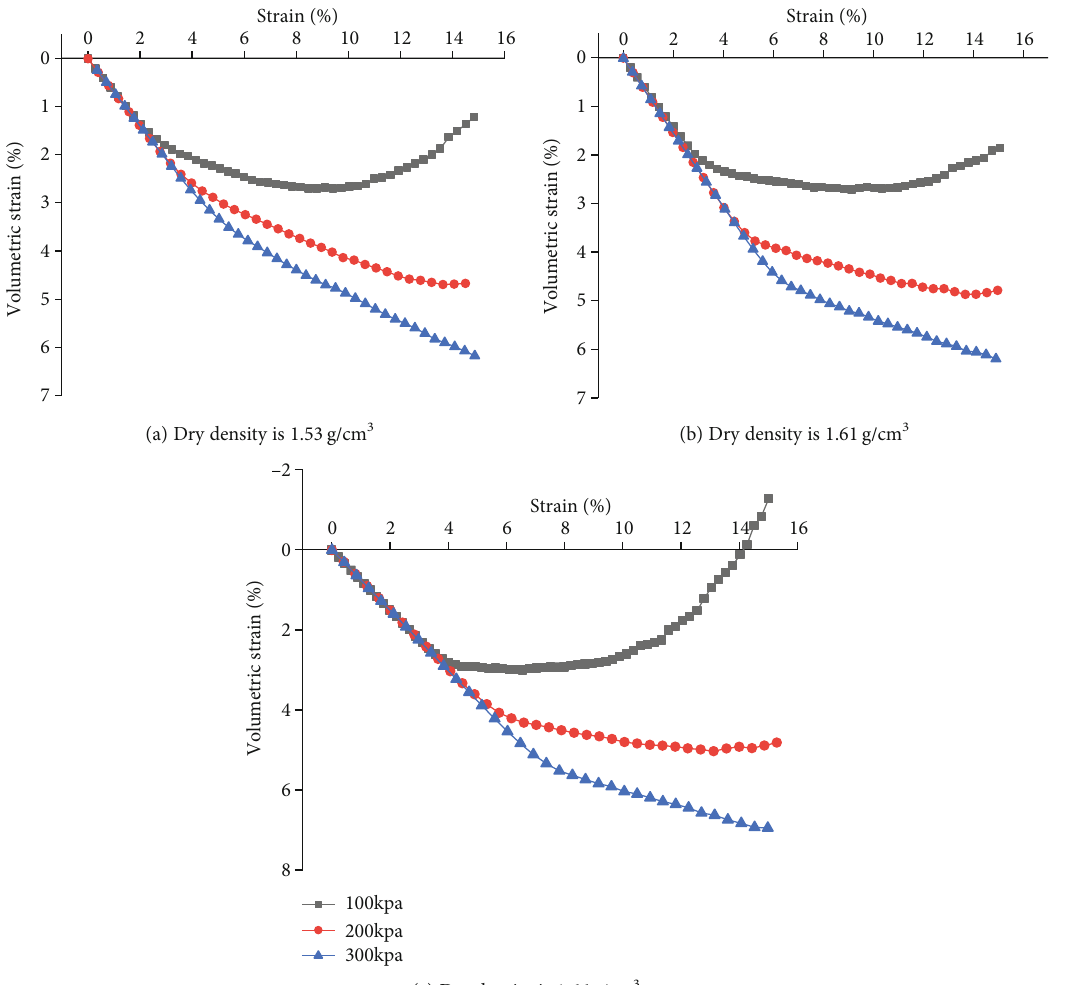
Figure 8: The relation curve of axial strain and volume strain in PFC numerical simulation.